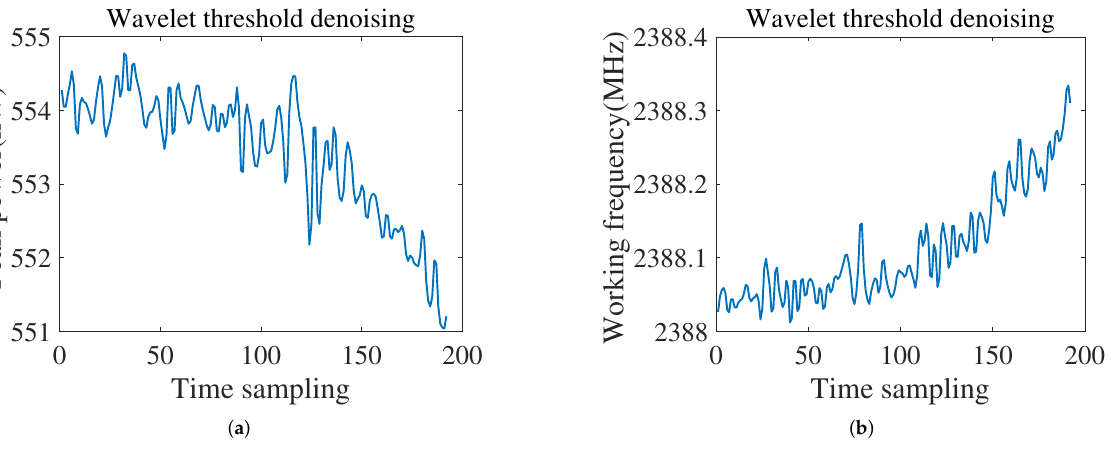
Figure 4. The monitoring data after denoising of the first type of degradation malfunction. ( a ) Peak power. ( b ) Working frequency.